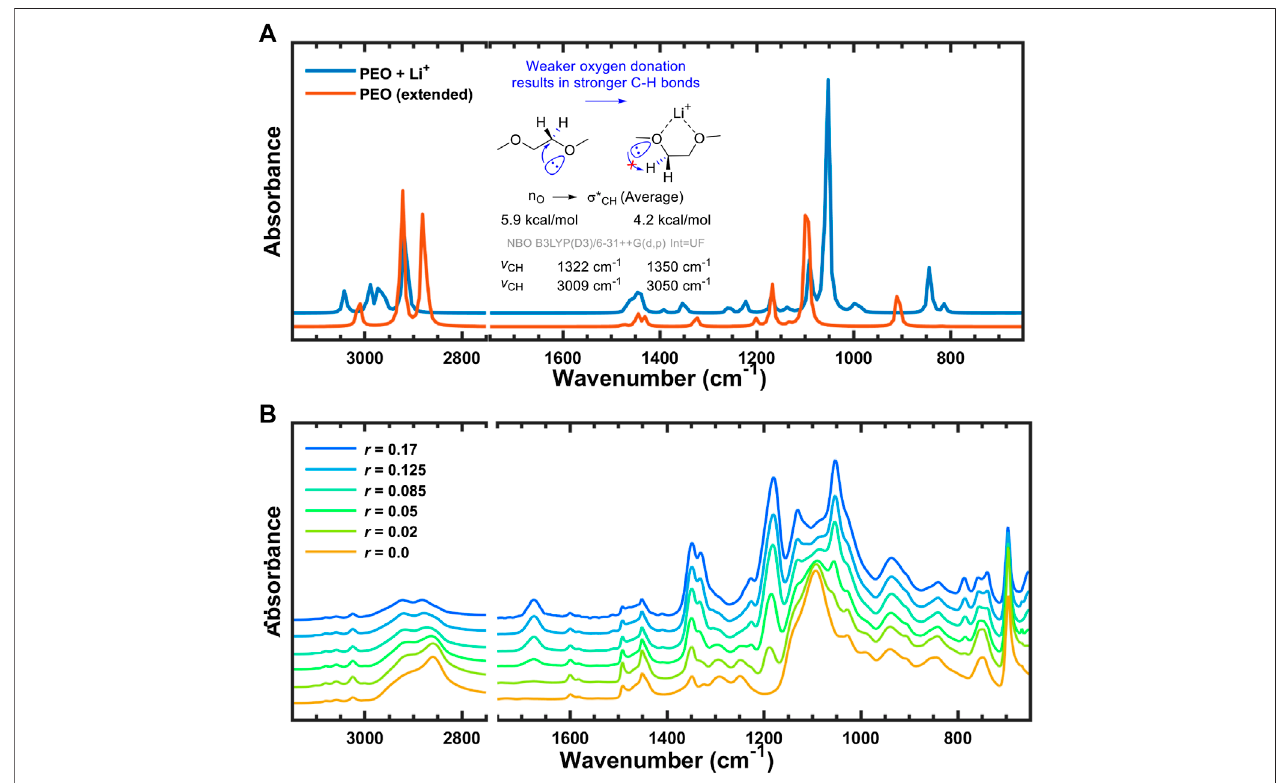
Figure 12 | (A) FTIR-ATR spectra of LiTFSI + NMP, dry LiTFSI and solid LiTFSI powder, and (B) time-resolved FTIR-ATR spectra of SEO/LiTFSI with diffusion.